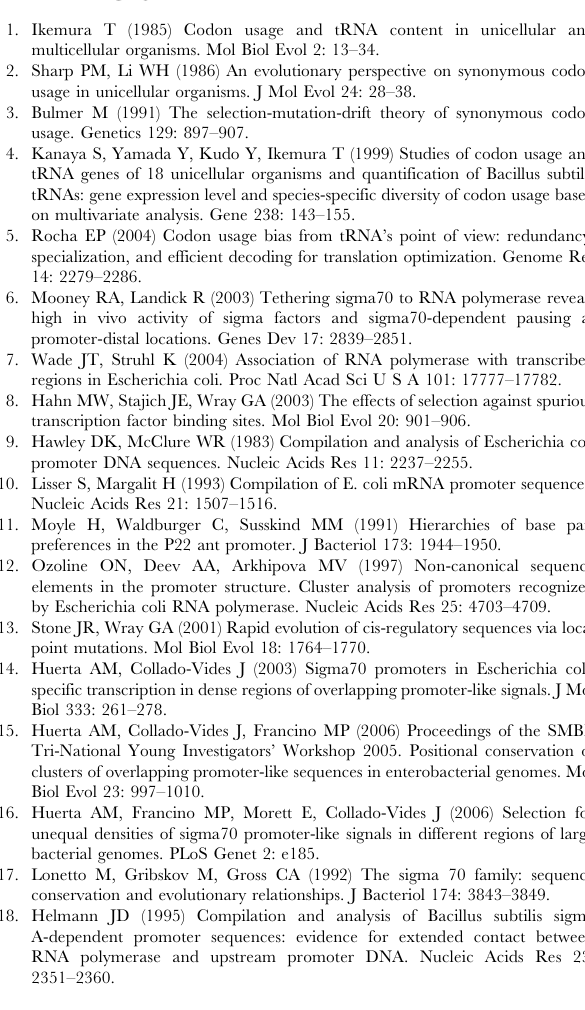
Table S4 Observed vs. expected counts of 2 10 motifs in coding regions. Total Sequence Length is the total number of base pairs analyzed for the corresponding type of region in each genome. NSD is the number of standard deviations that separate the observed motif count from the expected mean in that genome, NSD =